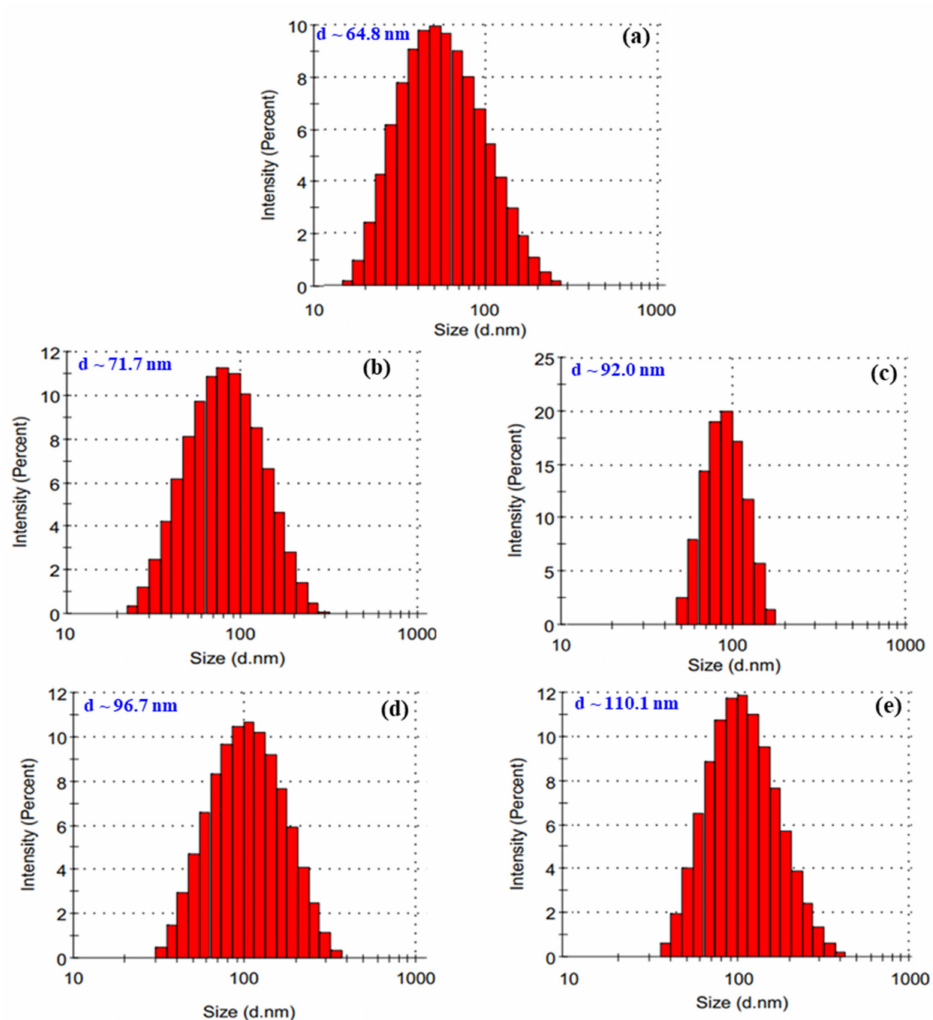
Figure 2. Particle size and size distribution of SeNPs/ β -glucan samples with various Se 4+ concentrations syntheiszed by irradiation. ( a ) 40 ppm; ( b ) 60 ppm; ( c ) 80 ppm; ( d ) 100 ppm and ( e ) 120